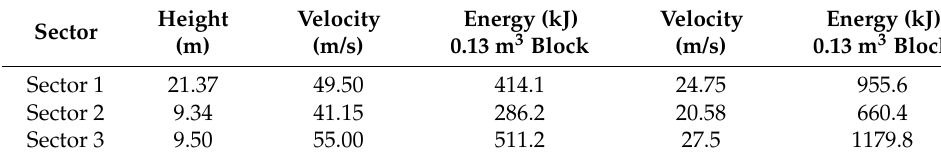
Table 7. Height and velocity (percentile 95%) and kinetic energy—Phase